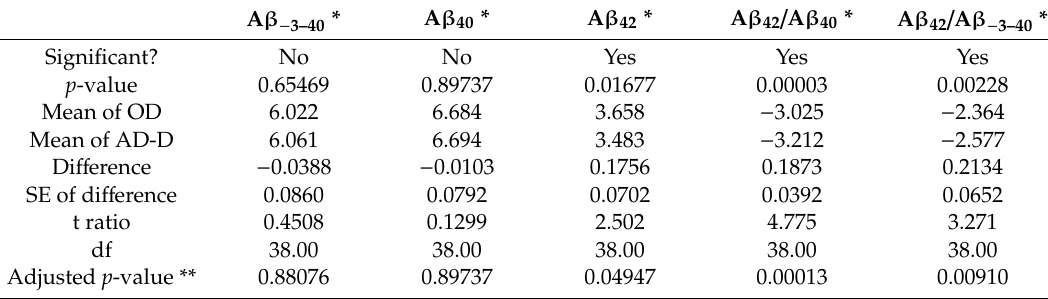
Table 9. Comparison of means (log2 transformed data) between the diagnostic groups by multiple t -tests. AD-D, Alzheimer’s type dementia; OD, other dementias.